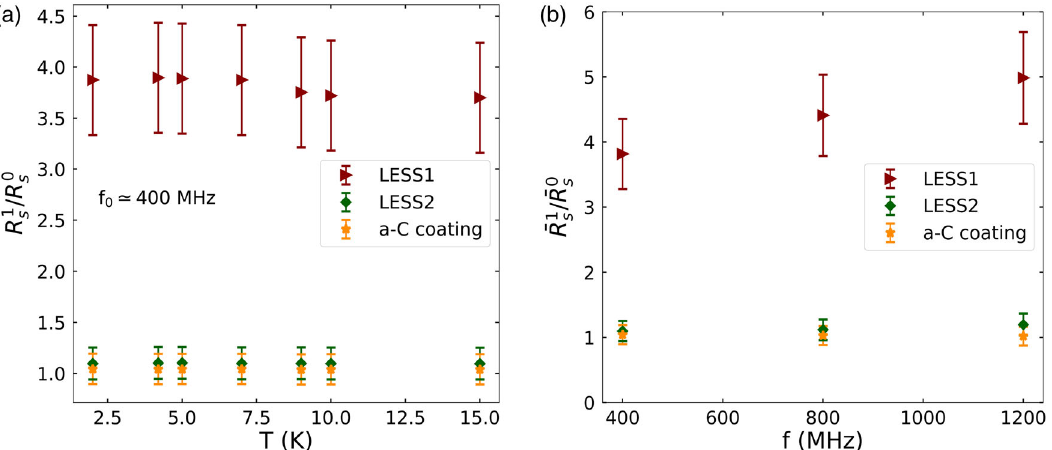
FIG. 6. (a) Relative increase of the surface resistance with respect to pristine copper as a function of the temperature for the different surface treatments. (b) Relative increase of the average surface resistance with respect to pristine copper as a function of the frequency for the different surface treatments. Error bars are estimated from measurement uncertainty